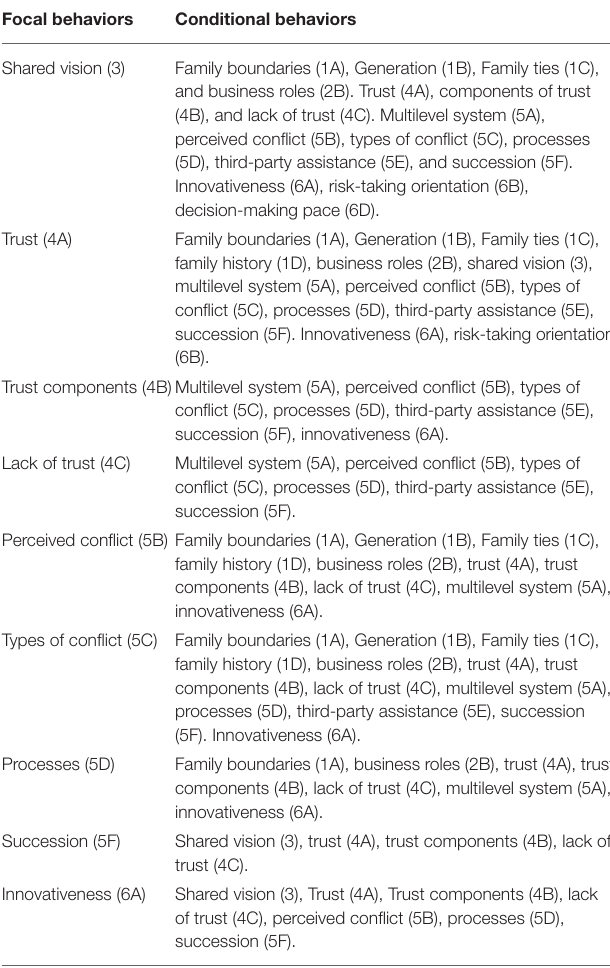
TABLE 5 | List of focal and conditional behaviors selected for